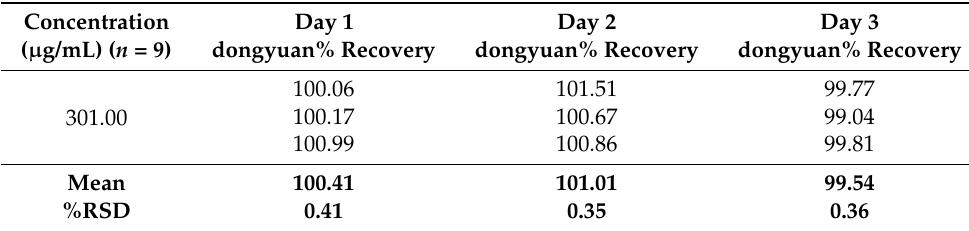
Figure 3. Overlay of chromatograms obtained with ( a ) mobile phase, pH 1.2, pH 4.5, and pH 6.8 buffered media and distilled water; ( b ) PDX and TZD dissolved in the described diluent. 3.6. Robustness The robustness testing for this method applied deliberate adjustments to the chroma- tographic parameters. Adjustments were made to the detection wavelength, resulting in the testing of chromatographic response at 230, 250, and 280 nm. Table 5 provides an out- line of the obtained area under the curve (AUC) values for both PDX and TZD. From these deliberate changes, it was observed that PDX exhibits a higher AUC at wavelength 250 nm, while TZD shows the highest AUC response at 280 nm. Based on these results, it was concluded that using a detection wavelength of 260 nm provides the best detection for both compounds. Deliberate changes to the column temperature were also tested during robustness testing. The column temperatures varied from ambient temperature to 40 °C. It was noted that changes in the column temperature did not affect the retention time of each of the compounds significantly, and therefore it was not identified as a critical chro- matographic parameter for this method.